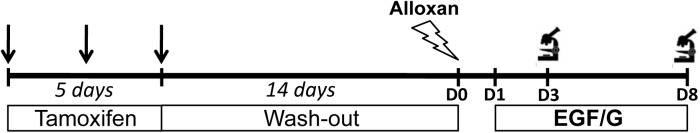
Scheme of the experimental design.